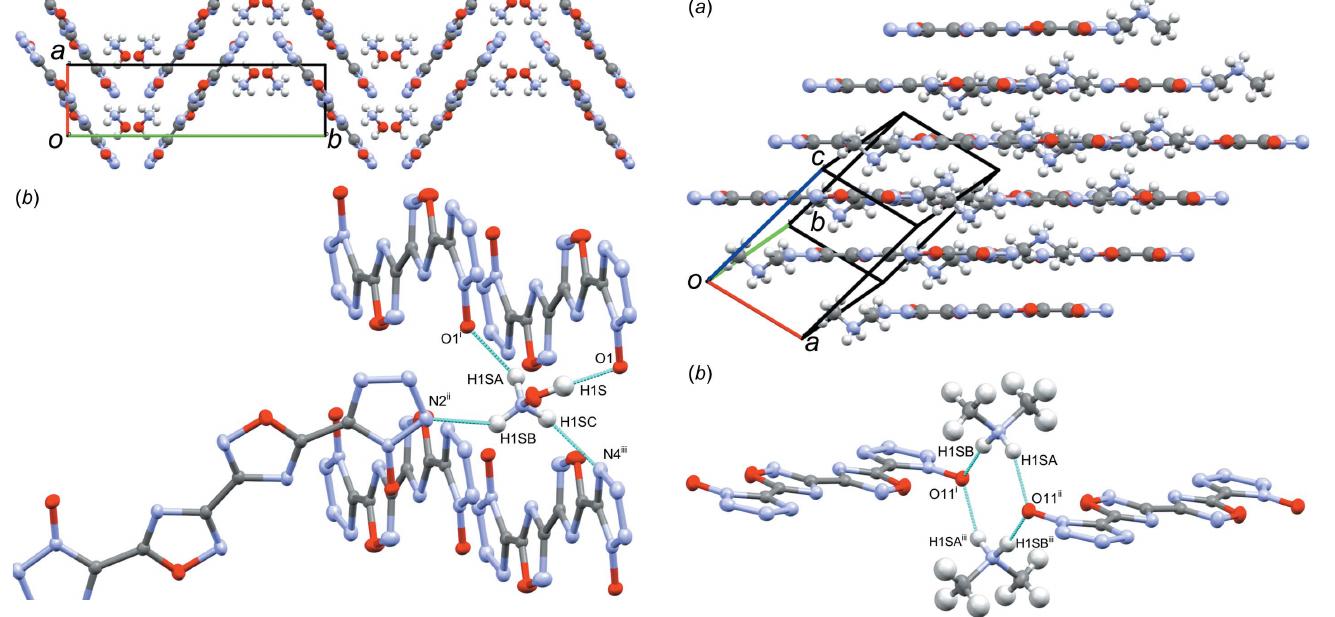
Figure 7 ( a ) Wavelike packing of 2 as seen down the c -axis, showing the opposing columns of dianion with hydroxylammonium occupying the space between the columns, and ( b ) view highlighting the hydrogen-bonding network (intermolecular contacts) between hydroxylammonium cation and the dianions. [Symmetry codes: (i) x (cid:3) 1, y , z ; (ii) x (cid:3) 1, (cid:3) y + 3 (iii) x , y , z +